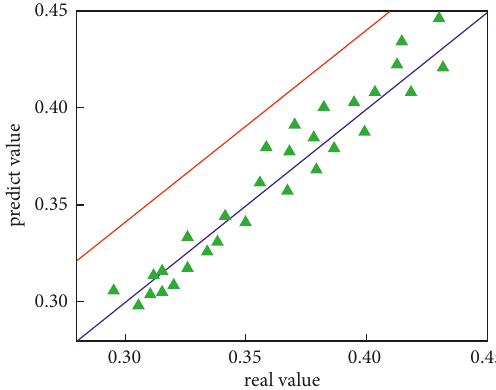
Figure 9: Linear correlation of predicted values for classical music.